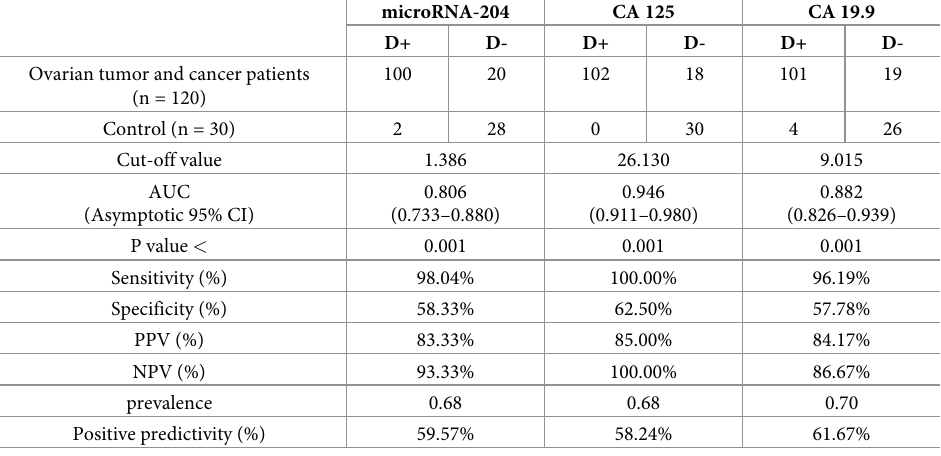
Charkhchi et al., [4] who demonstrated that serum CA125 levels are high in 50% of early-stage tumors (mainly type I ovarian cancers) and 92% of advanced-stage tumors (mainly type II ovarian cancers). Moreover, CA125 is elevated in other cancers or benign conditions [20]. CA19.9 is a glycoprotein complex found on the surface of cells and has been linked to pan- creatic duct carcinoma [21]. Our results demonstrated that CA19.9 is increased significantly in benign, early, and late ovarian cancer patients compared with CA19.9 levels in healthy control patients. According to Al-dujaili et al. [22], serum CA19.9 concentrations are high in up to 35% of patients with endometrial cancer and can be employed in follow-up examinations of Table 8. Sensitivity, specificity, positive predictive value, negative predictive value, and AUC of hepcidin, MAGP2, and ferroportin for diagnosing ovarian cancer. Hepcidin MAGP2 Ferroportin D+ D- D+ D- D+ D- Ovarian tumor and cancer patients - 120 - 120 2 118 (n = 120) Control (n = 30) - 30 - 30 - 30 Cut-off value 463 106 106 AUC 0.108 0.229 0.048 (Asymptotic 95% CI) 0.058–0.158 0.146–0.312 0.016–0.081 P value < 0.001 0.001 0.001 Sensitivity (%) 80.00% 80.00% 96.19% Specificity (%) 20.00% 20.00% 57.78% PPV (%) - - 1.67% NPV (%) - - 100.00% prevalence - - 0.01 Positive predictivity - - 68.68% D + = Positive disease; D- = Negative disease, PPV, positive predictive value; NPV, negative predictive value; AUC, area under the curve; 95% CI, 95% confidence interval.